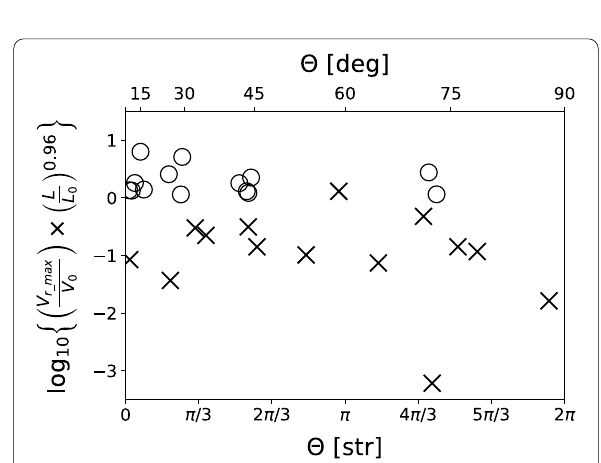
Fig. 4 Plot of filament eruptions according to Θ (inclination angle in steradians and degrees) and a common log of the LHS of Eq. (1). The symbols have the same meaning as in Fig. 1